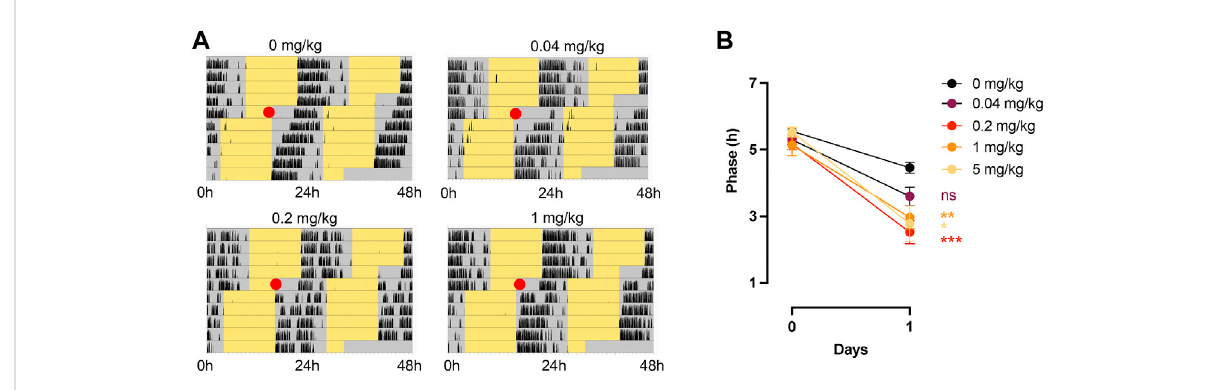
FIGURE 2 Effect of CT1500 on photic re-entrainment. (A) C57Bl6/J ( n = 10 – 12 per group) male mice housed in a 12:12 LD (Light Dark) cycle, yellow indicates lights on, grey lights off, and black wheel running activity and at the red dot (ZT6) received a single indicated dose of CT1500 and the LD cycle immediately advanced by 6 h. Representative actograms shown. (B) Phase of activity onset relative to lights off on the subsequent day plotted anddataanalysed(datawerefoundtofollowanormaldistribution,Anderson-Darlingtest)byTwo-wayANOVA.Asigni fi canteffectofdosewas observed (F = 242, p < 0.001), Tukey ’ s multiple comparisons tests are as follows (0.04 mg/kg vs . 0 — difference = 0.8616, adj. P = 0.43; 0.2 mg/kg vs . 0 — difference = 1.929; adj. P = 0.0001; 1 mg/kg vs . 0 — difference = 1.486, adj. P = 0.004; 5 mg/kg vs. 0 — difference = 1.670, adj. P = 0.024. The